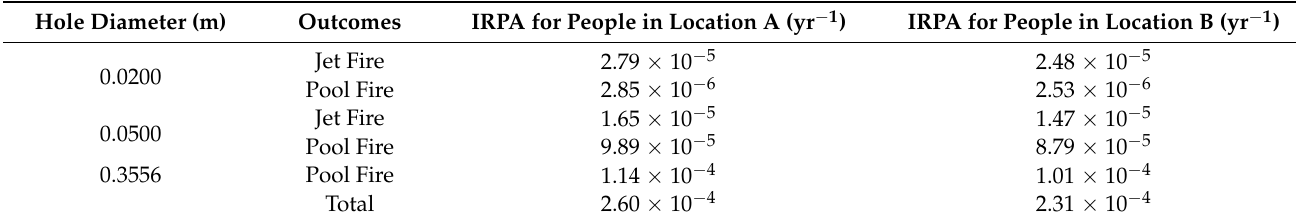
Table 10. Individual risk per annum for people in the locations A and B.